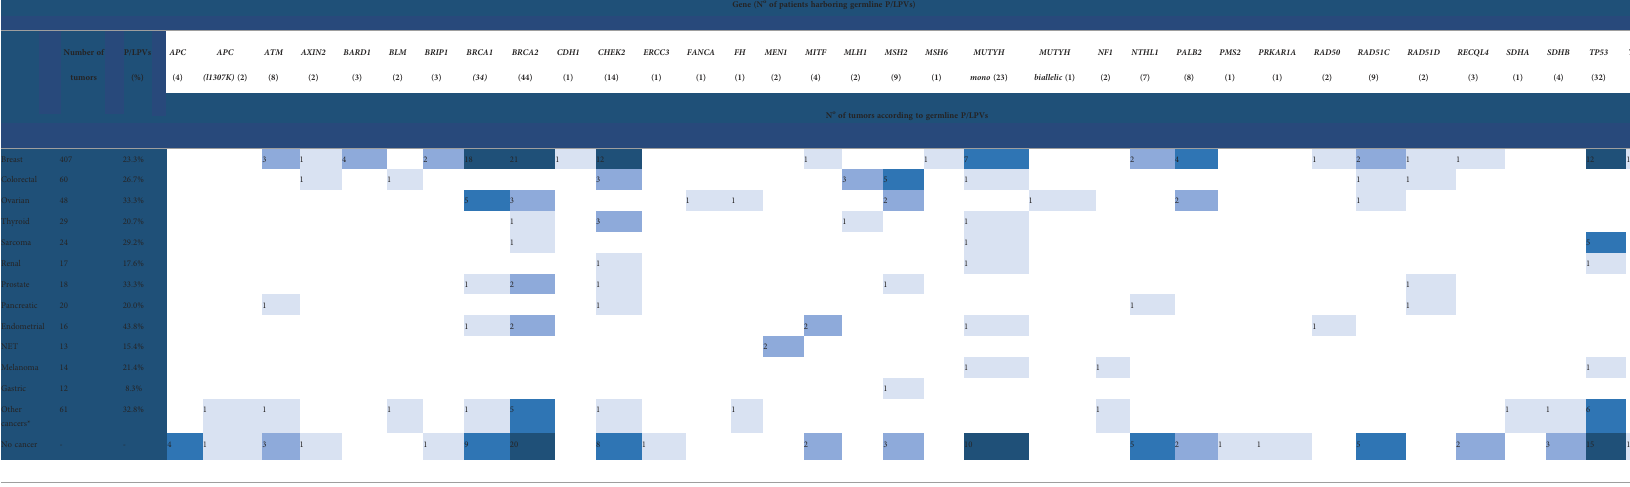
Gene(N o ofpatientsharboringgermlineP/LPVs)